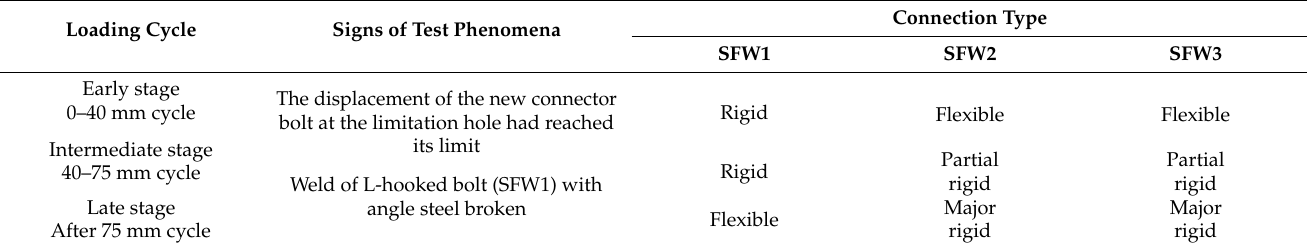
Table 4. Connection types of specimens by displacement loading.